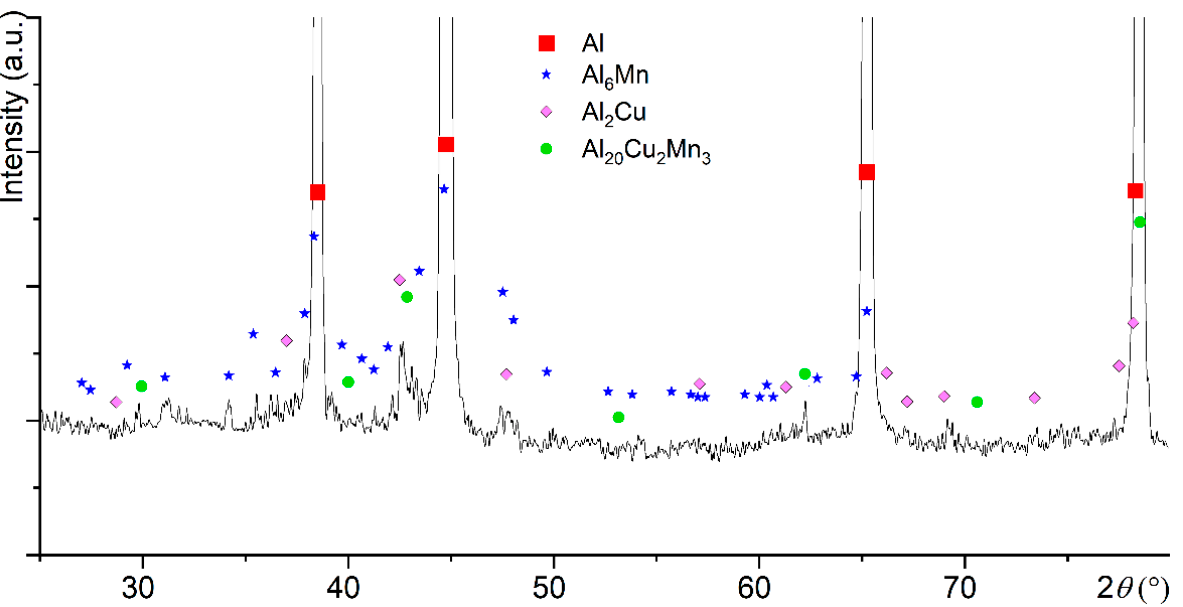
Figure 1. XRD data for the Al-2%Cu-2%Mn as-cast alloy studied (Cu K- α radiation). In the SEM structure of as-cast alloy, the grey-colored aluminum solid solution matrix phase and bright areas of constitutes phases enriched with Cu, Mn, and both Mn and Cu were observed (Figure 2). The morphology of the secondary phases and EDS data suggested that the bright areas belonged to solidification-originated θ -Al 2 Cu, Al 6 Mn, and T -Al 20 Cu 2 Mn 3 phases. The total volume fractions of the secondary phases was 1.8 ± 0.2%, with 1.0 ± 0.1% of θ -Al 2 Cu phase. According to SEM-EDS data, the (Al) solid solution contained 1.7 ± 0.2 wt.% Mn and 1.2 ± 0.3 wt.% Cu in as-cast state. The dendrite liquation of Cu, which enriched periphery of dendrite cells, was observed. The phase composition